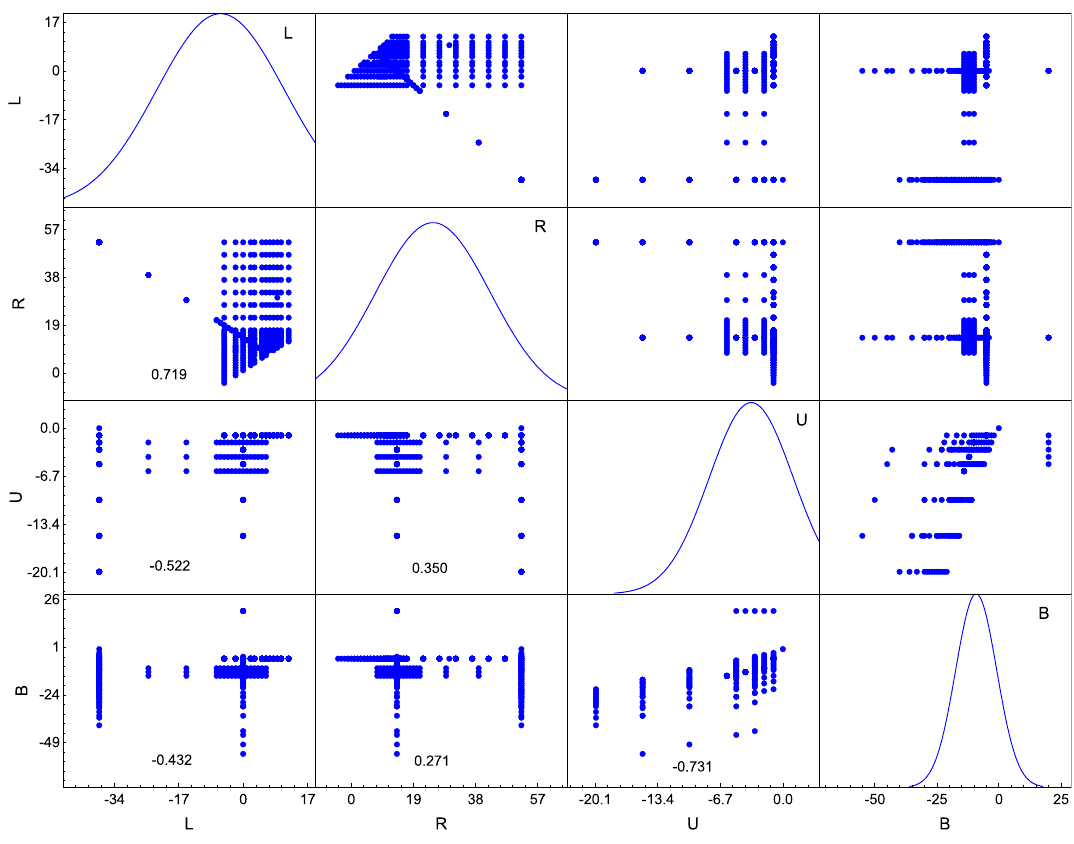
Figure 17. Distributions and correlation coefficients of model input variables in the data